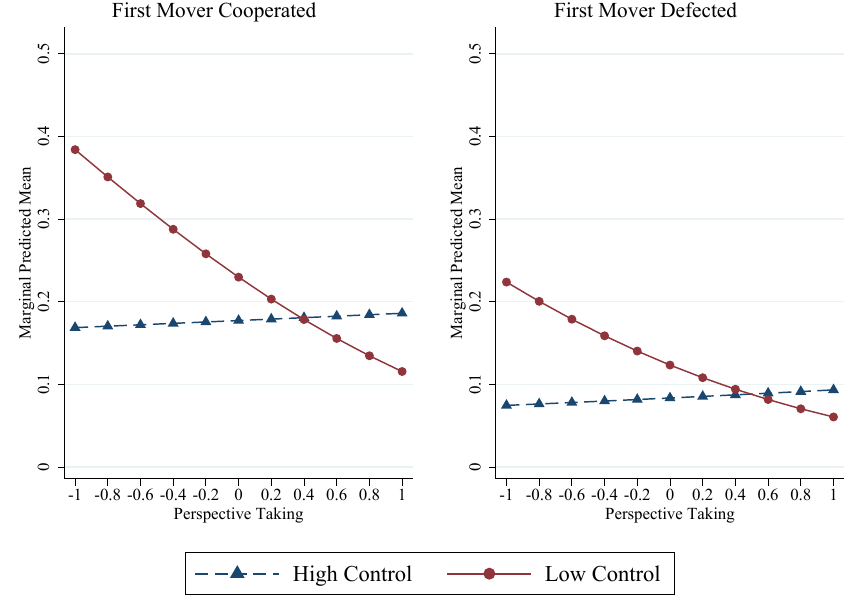
Figure 6. Probability by Perspective Taking in Known Treatment (First 10